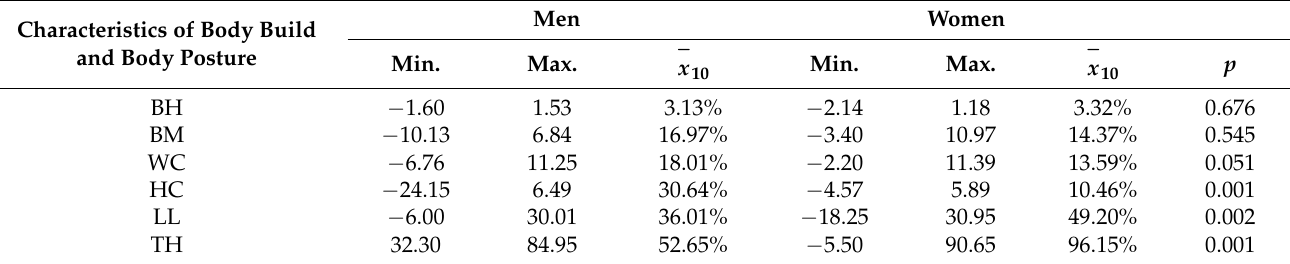
Table 4. Relative increments based on chain indices for body posture and body build in men and women [%]. Characteristics of Body Build and Body